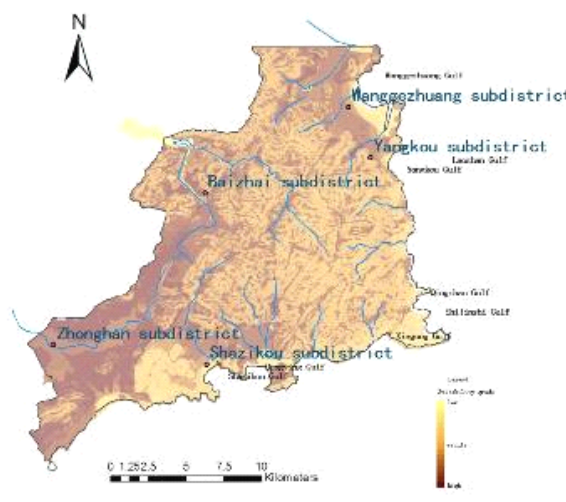
Fig. 6. Geo-environmental suitability map 4 Discussion